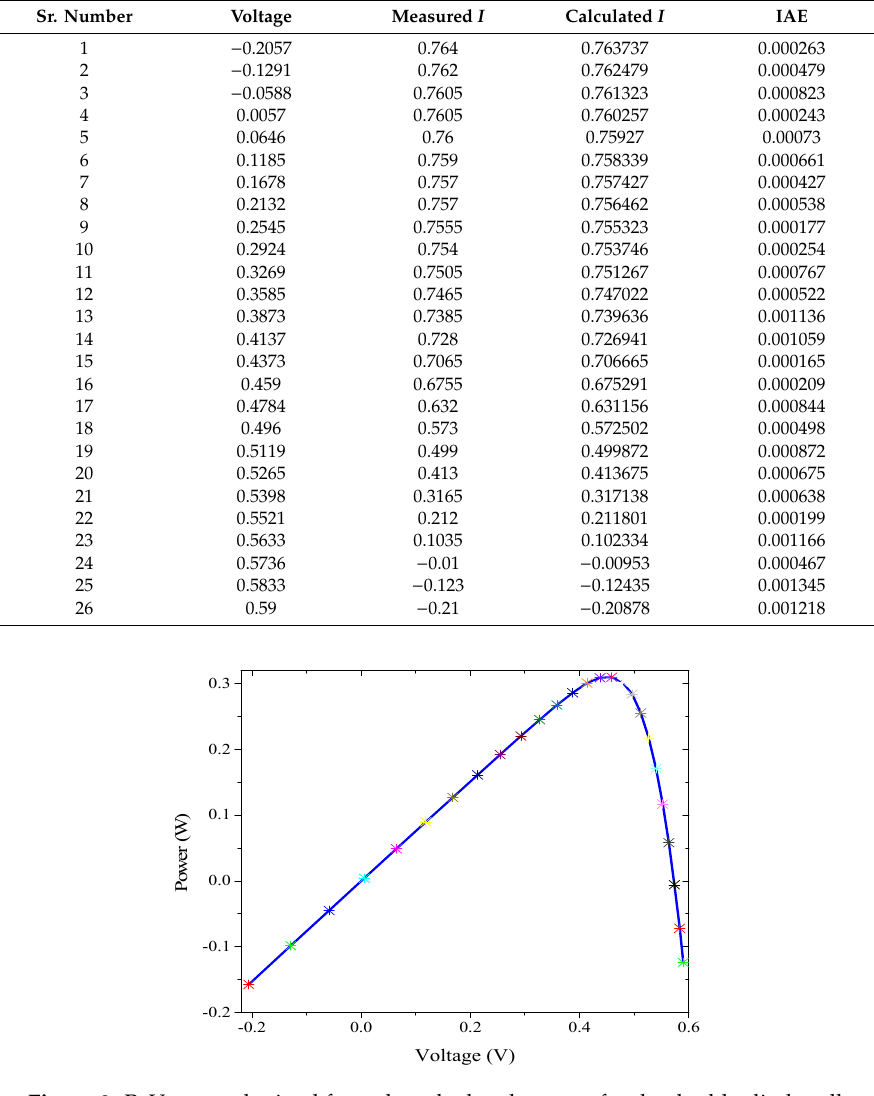
Table 6. I–V values and the relative IAE for the double-diode cell.